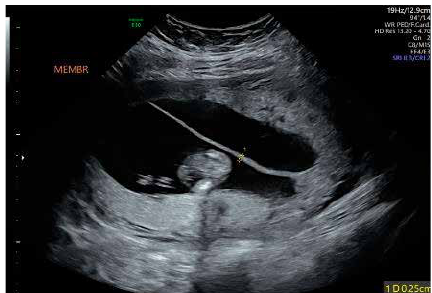
Figure 3: Patient at 13 + 3 weeks EGA with reabsorbed hemorrhage. Thickness now 2.5